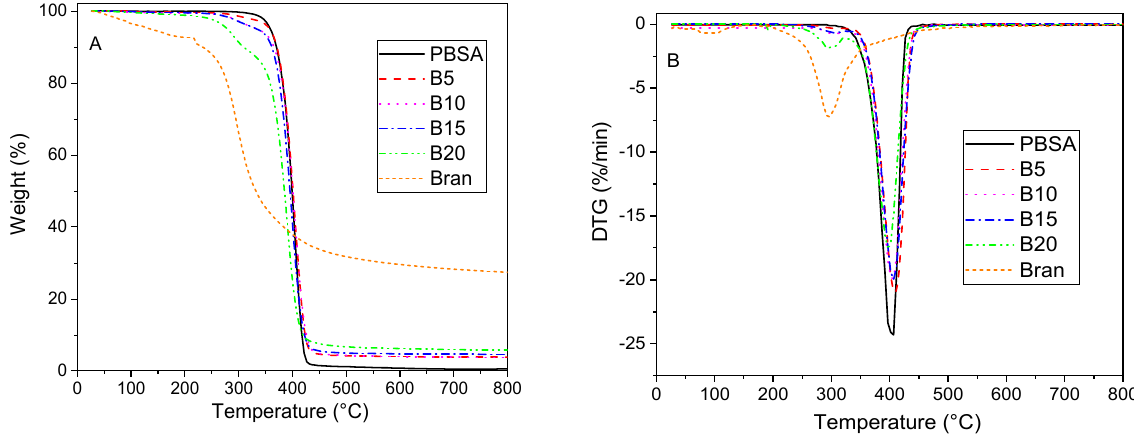
Figure 2. ( A ) TG and ( B ) DTG curves of bran, virgin PBSA, and PBSA/B composites (B5, B10, B15, and B20) under nitrogen atmosphere at a heating rate of 10 °C/min.